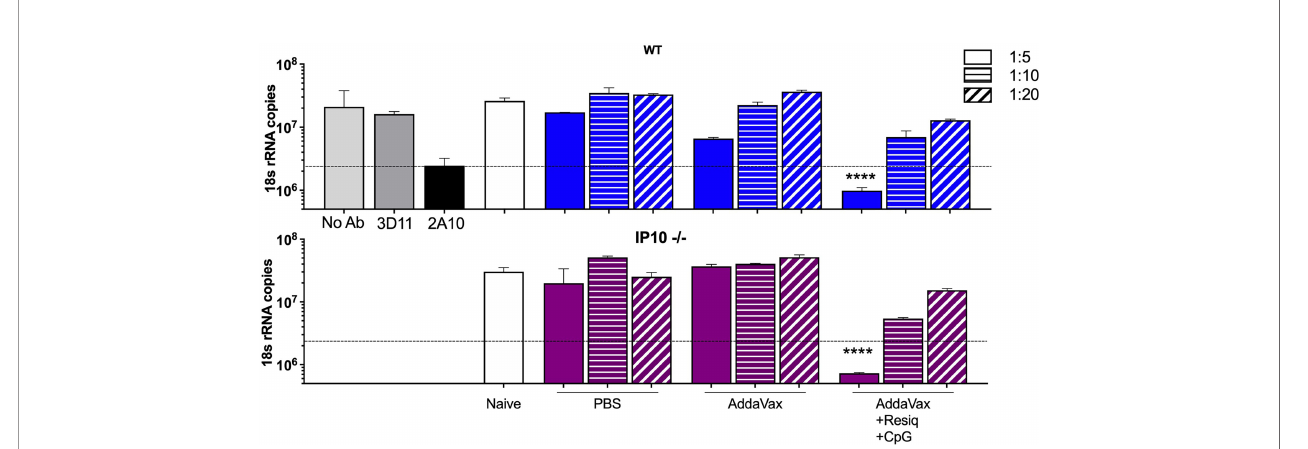
FIGURE 7 | Sporozoite neutralizing antibody in hyperimmune serum of SS immunized IP-10 -/- compared to WT mice. TSNA was carried out with pooled immune sera (5 mice/group) obtained post 4 th SS immunization from WT (upper panel, blue bars) or IP-10 -/- mice (purple bars) tested in parallel at 1:5 – 1:20 serum dilution. Controls (grey bars) include PfPb sporozoites incubated with inhibitory MAB 2A10 or with negative control MAB 3D11 or without antibody (No Ab). Dotted line represents >90% inhibition of parasite levels in liver cell cultures measured by qRT-PCR. Signi fi cant reduction of parasite copy number was obtained with hyperimmune serum from both IP-10 -/- mice and WT mice following four SS immunizations with peptide in AddaVax + Resiquimod + CpG compared to serum from naïve mice (one-way ANOVA of log-transformed data with Dunnett ’ s multiple comparisons test and adjusted p values, ****p